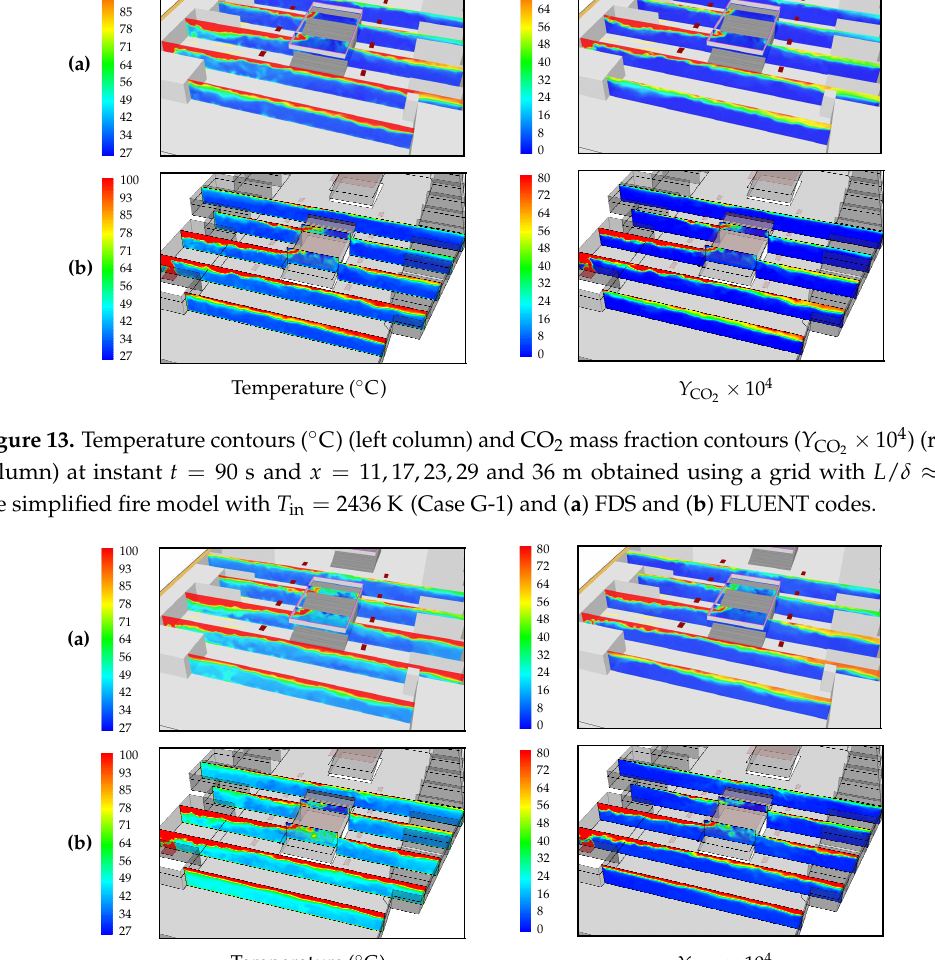
Figure 14. Temperature contours ( ◦ C) (left column) and CO 2 mass fraction contours ( Y CO (right column) at instant t = 240 s and x = 11,17,23,29 and 36 m, obtained as in Figure 13. ( a ) FDS; ( b )